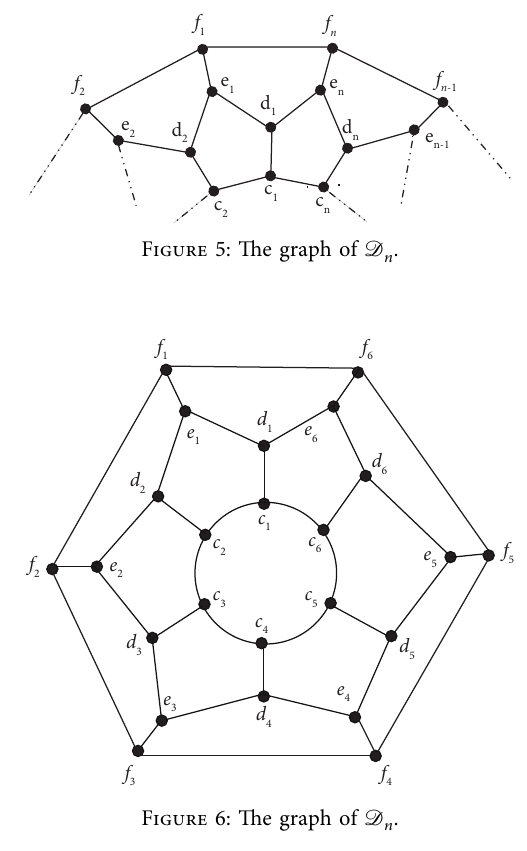
Figure 5: Te graph of D